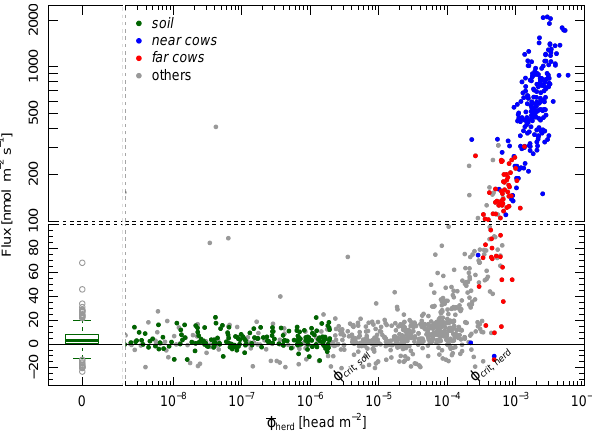
Figure 6. Observed CH 4 fluxes plotted against the mean herd foot- print weight ( ϕ herd ). Cases selected for the calculation of the soil flux (green) and cow emissions (blue/red) are marked in dark col- ors. The remaining points (gray) represent discarded outliers and cases with intermediate ϕ herd values (i.e., with low but not negligi- ble cow